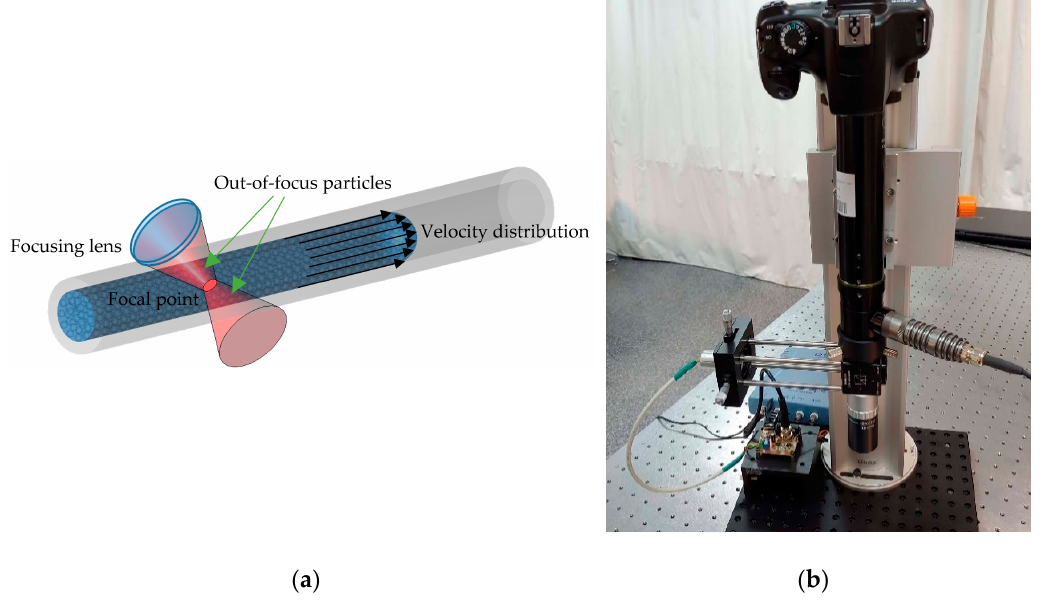
Figure 6. ( a ) Diagram of the interaction of a focused laser beam on particles that flow at different velocities within a capillary. ( b ) Confocal SMI-based Doppler flowmeter (SMDF) developed by Yáñez et. al. [91], which allows reconstructing the flow profile of liquids flowing in capillaries. This prototype is projected as a useful tool in the diagnosis of sprouting angiogenesis.